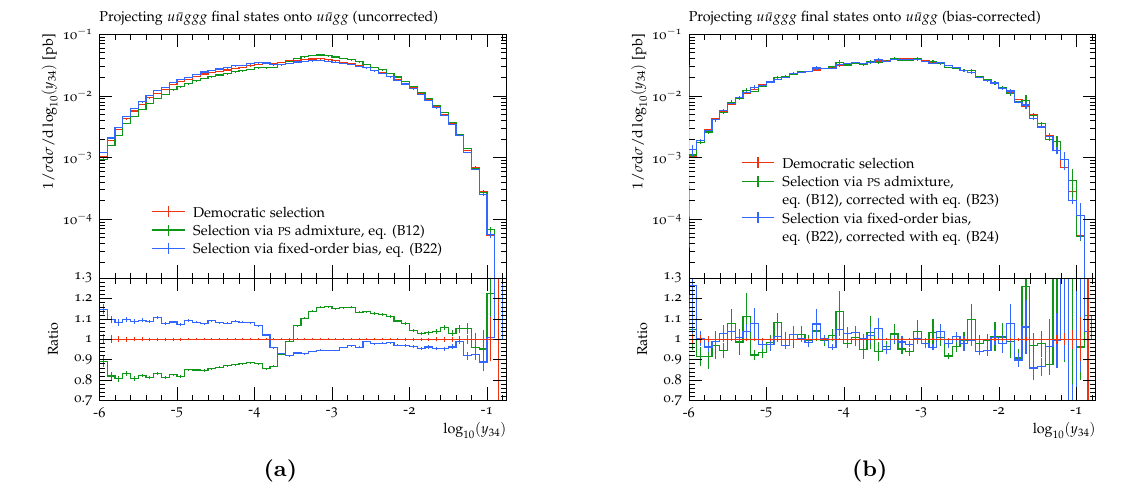
Figure 7 . Assessment of clustering strategies and bias corrections. (a) Impact of different clustering strategies on four-parton observables. (b) Four-parton observable results, using 1 3 onto a democratic clustering